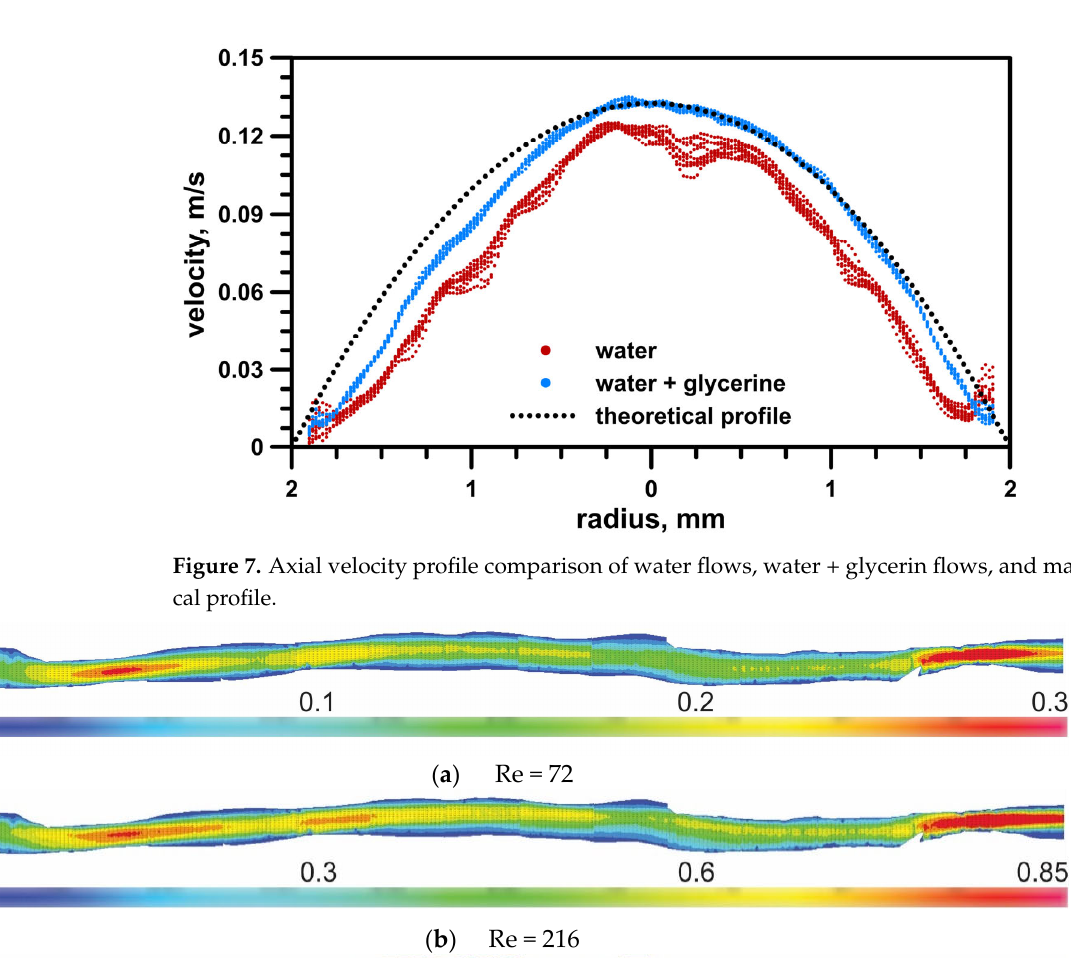
Figure 7. Axial velocity profile comparison of water flows, water + glycerin flows, and mathematical profile.